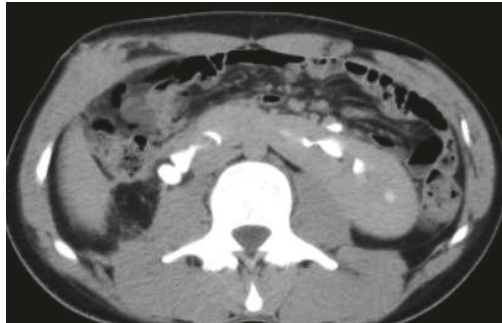
Figure1:InitialpreoperativeCE-CTscan(coronalsection)showing horseshoe kidney with right hydronephrosis.